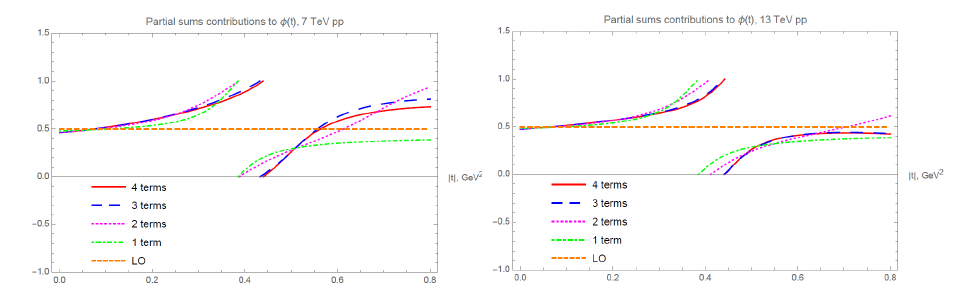
Figure 6. The principal value of the nuclear phase φ 2 ( t ) with the contributions of the partial sums from the leading order to fourth order Levy expansion, as fitted to the TOTEM pp elastic scattering data at √ s = 7 TeV (left panel) and at √ s = 13 TeV (right panel), respectively. Note that stability of the point where φ 2 ( t ) = π for increasing order of the expansion, and for changing the energy of the collision.